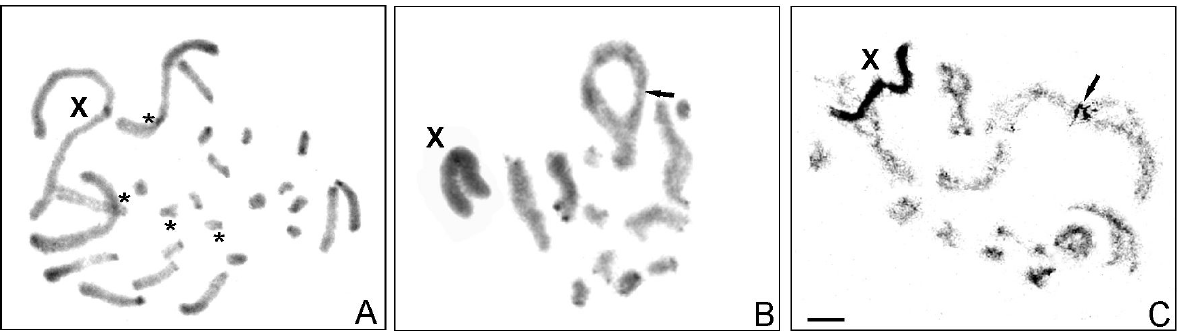
Figure 53. Chromosomes of Morgenia lehmannorum sp. n.; C-banded mitotic metaphase ( A ) and diakinesis ( B ) as well as silver nitrate staining of diakinesis ( C ) of male complement. Arrows indicate secondary construction region in the largest arm of biarmed chromosome ( b ) which correspond to the presence of one active NOR ( c ). An asterisk indicates biarmed medium and small pairs. X, sex chromosome. Scale bars = 10